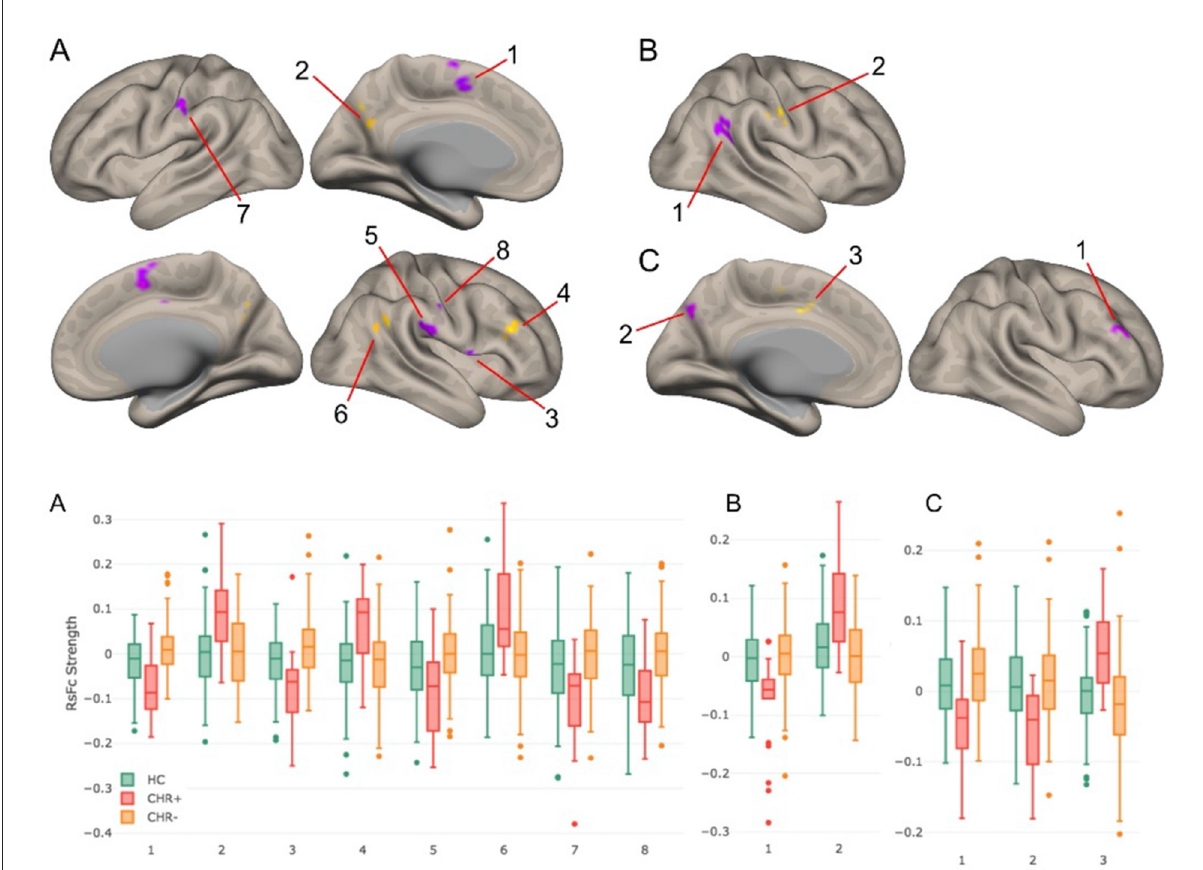
FIGURE2 Top panel : RsFc results for CHR + vs. CHR– contrast at a voxel-level height threshold of p < 0.005 (2-sided) and cluster size FDR corrected threshold of p < 0.05. (A–C) correspond to DMN, salience-motor, and visual functional territories of DN. Bottom panel : Bar plots for each of the significant clusters in the healthy control, CHR + , and CHR– groups. Notably, for each of these group contrasts, CHR– participants were not significantly different compared to healthy controls